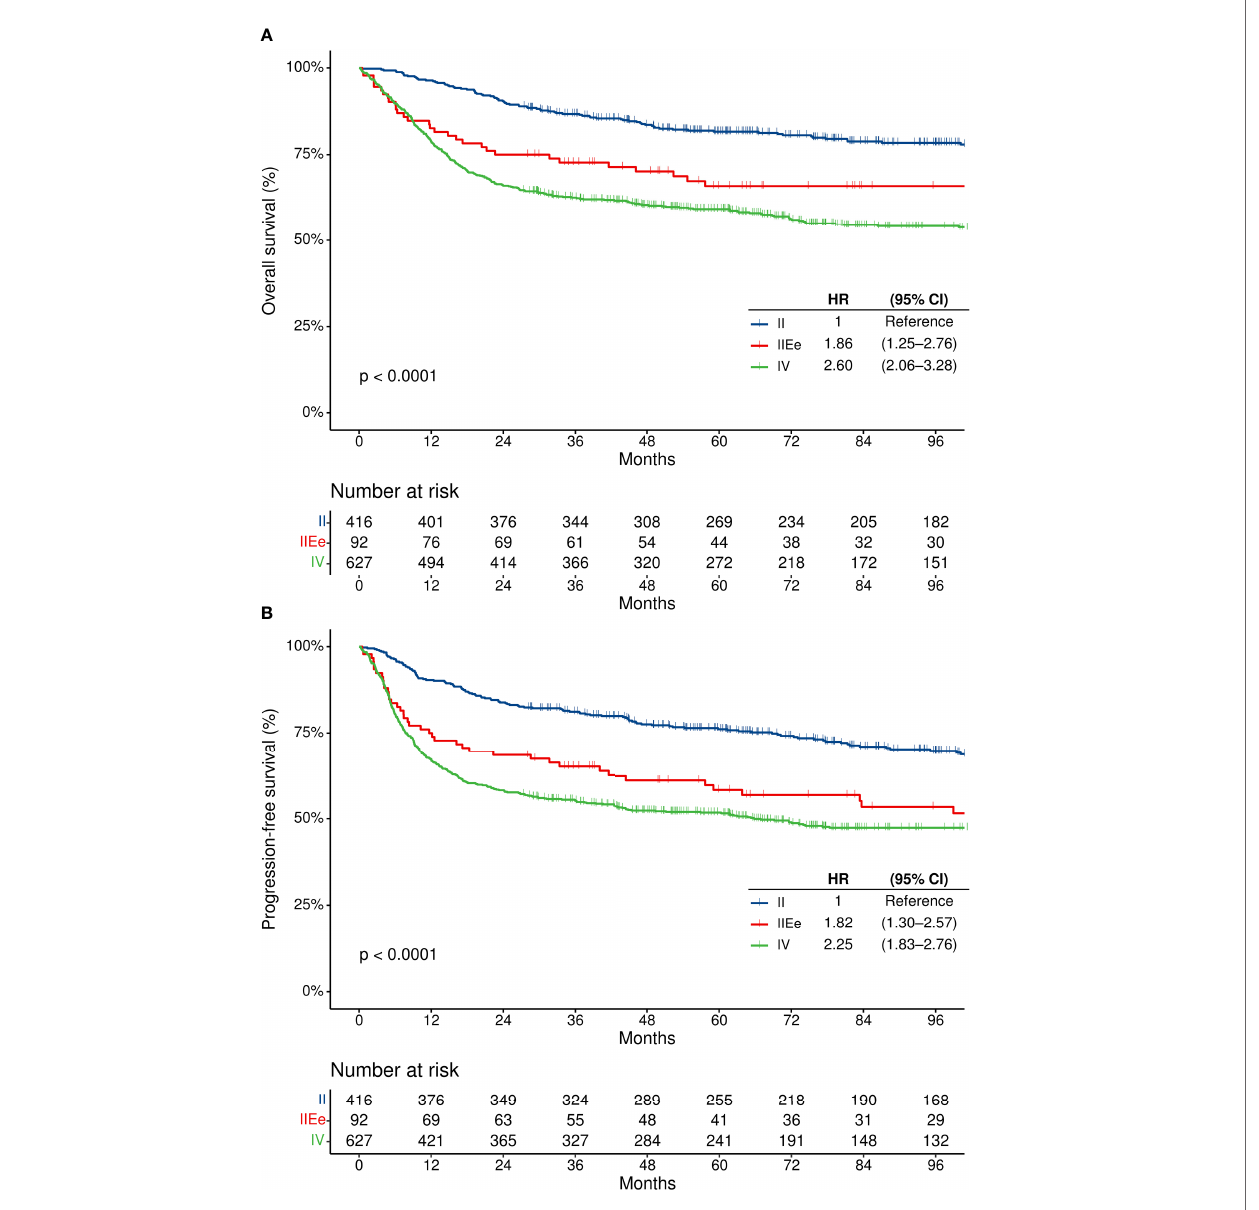
FIGURE 4 | Survival outcomes according to the modi fi ed staging system. (A) Overall survival, and (B) progression-free survival. CI, con fi dence interval; HR, hazard ratio; OS, overall survival; PFS, progression-free